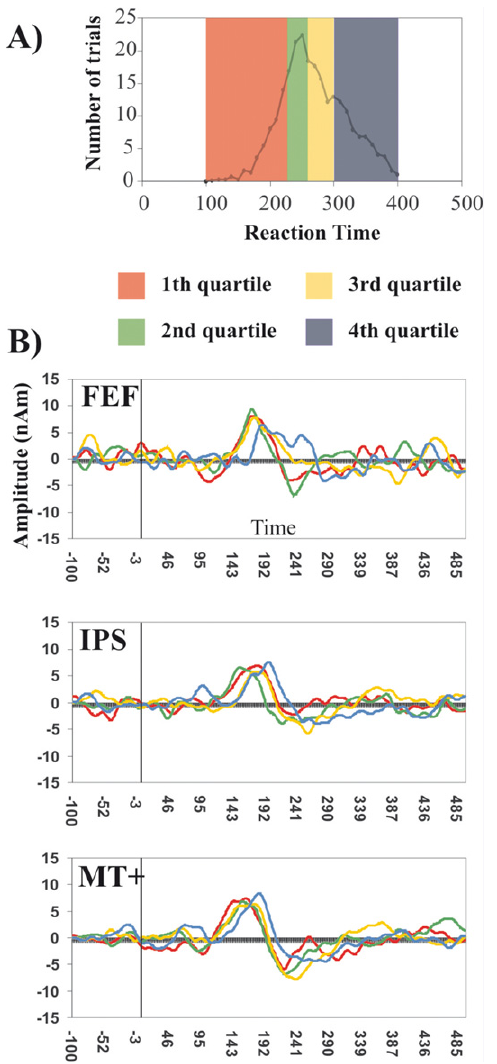
Figure 3. SRT Quartiles Analysis of MEG waveforms. (A) Frequency distribution of trials by SRTs. The different colors show the division of trials by quartiles. (B) Forward grand averages of MEG source waveforms from the three regions of interest: FEF (top row), IPS (central row) and MT + (bot- tom row) representing each quartile, collapsed across ipsi and contralateral regions. The black vertical line represents the visual stimulus onset.